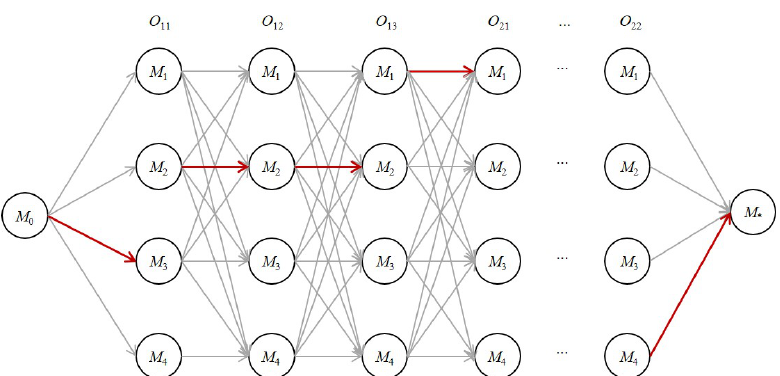
Figure 1. Illustration of random-key based representation.